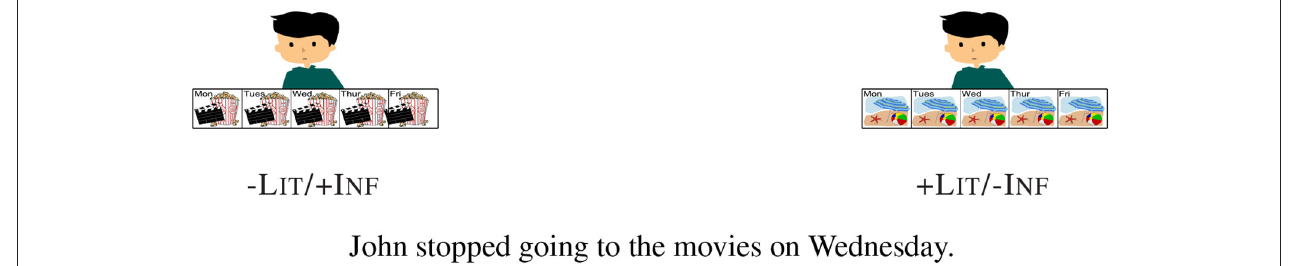
FIGURE 10 | Visual stimuli for inference vs. basic entailment-based rejections of stop in affirmative contexts.